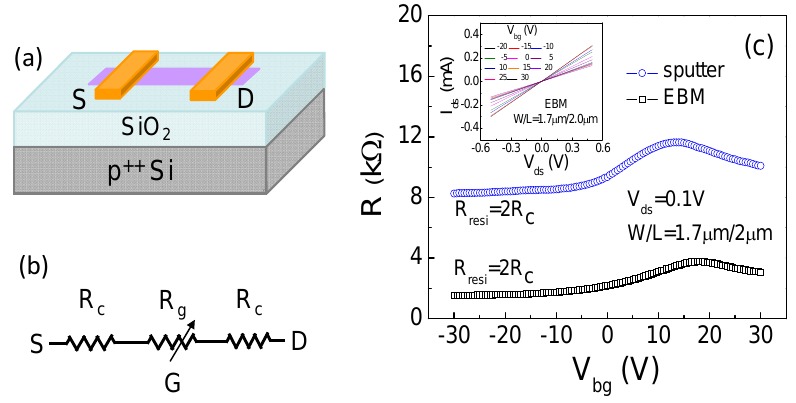
Figure 2. ( a ) The schematic of residual resistance measurement; ( b ) The equivalent circuit for graphene FETs. R can be modulated by back-gate voltage; ( c ) R − V plots of the g bg Ti/SLG device prepared by EBM and sputter processes, respectively. The residual resistance R equals to 2 R at high negative voltage. The I − V plots as a function of resi c ds ds are shown in the inset in Figure 2. R is larger for the sputtered Ti/SLG device than V bg c EBM